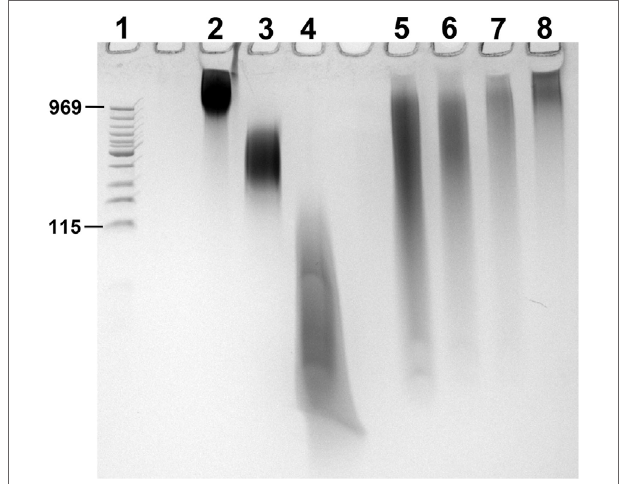
FigUre 1 | PAGE of RNA homopolymers and polyphosphate (polyP). PolyP preparations and RNA homopolymers used in this study were resolved by PAGE using a TBE-urea gel (10% polyacrylamide). 2 µg of each sample was loaded into the following lanes, with 2 M urea in the loading buffer: (1) low MW DNA ladder (with corresponding polyP sizes marked in terms of phosphate units); (2) long-chain polyP; (3) medium-chain polyP; (4) short-chain polyP; (5) polyI; (6) polyG; (7) polyC; and (8) polyA. PolyP and nucleic acids were stained for 5 min with 0.05% toluidine blue in 5% glycerol/25% methanol, and de-stained overnight in 5% glycerol/25%